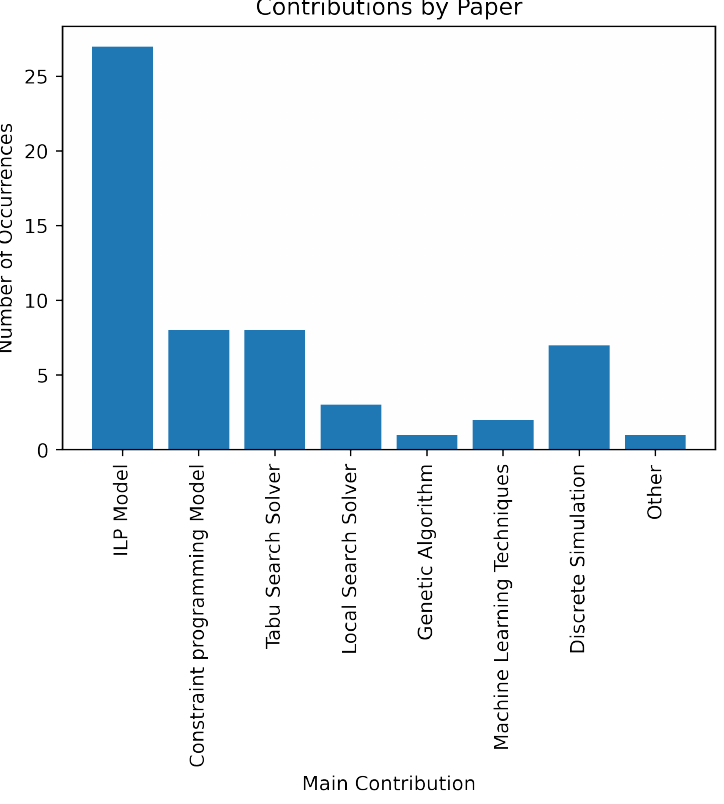
Figure 2. The distribution of